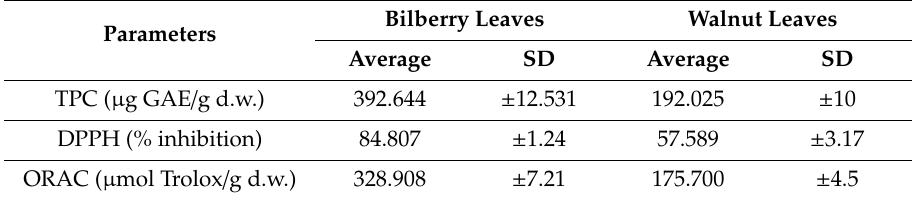
Table 2. Phytochemical characterization of plant material. Bilberry Leaves Walnut Leaves Parameters Average SD Average SD TPC ( µ g GAE / g d.w.) 392.644 ± 12.531 192.025 ± 10 DPPH (% inhibition) 84.807 ± 1.24 57.589 ± 3.17 ORAC ( µ mol Trolox / g d.w.) 328.908 ± 7.21 175.700 ±